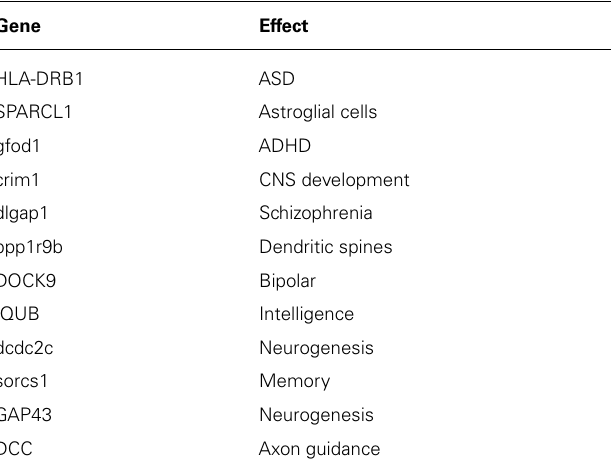
Table 3 | Summary of known biologically relevant genes found in common variant